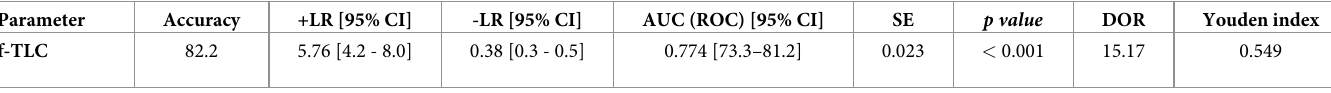
Fig 2. Receiver operating characteristics (ROC) curve of f-TLC showing the relationship between sensitivity (true positive) and 1 –specificity (true negative). https://doi.org/10.1371/journal.pone.0270235.g002 Table 5. Diagnostic performance criteria for f-TLC diagnosis of Buruli ulcer using PCR as a gold standard.